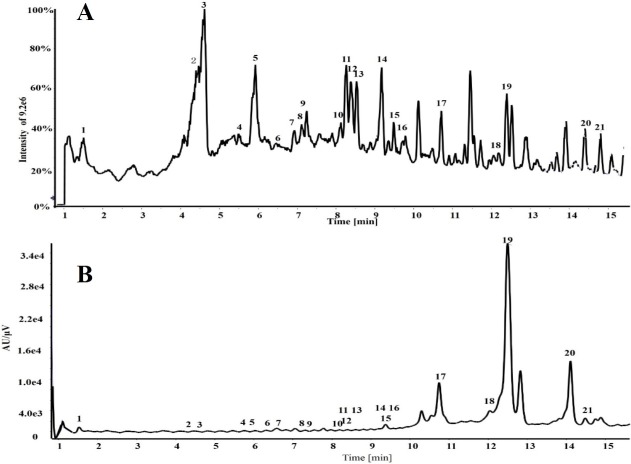
Total ion chromatogram of the C. nitidissima Chi flowers ethanolic extract (A); HPLC chromatogram of Camellia nitidissima Chi flower ethanolic extract by 360 nm detection (B).